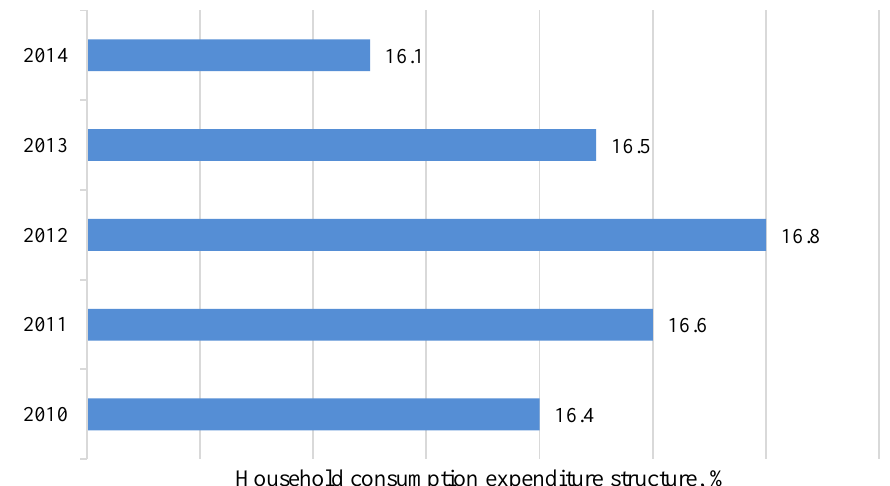
Fig. 3. The structure of household consumption expenditure (%) for the period of 2010–2014 in Latvia (Central Statistical Bureau, n.